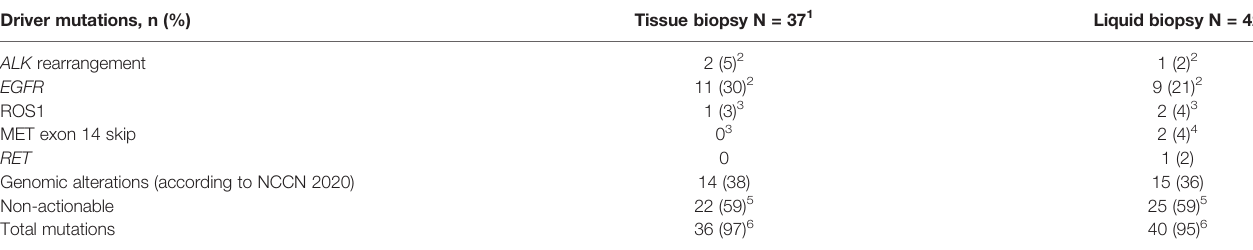
TABLE 2 | Molecular pro fi ling